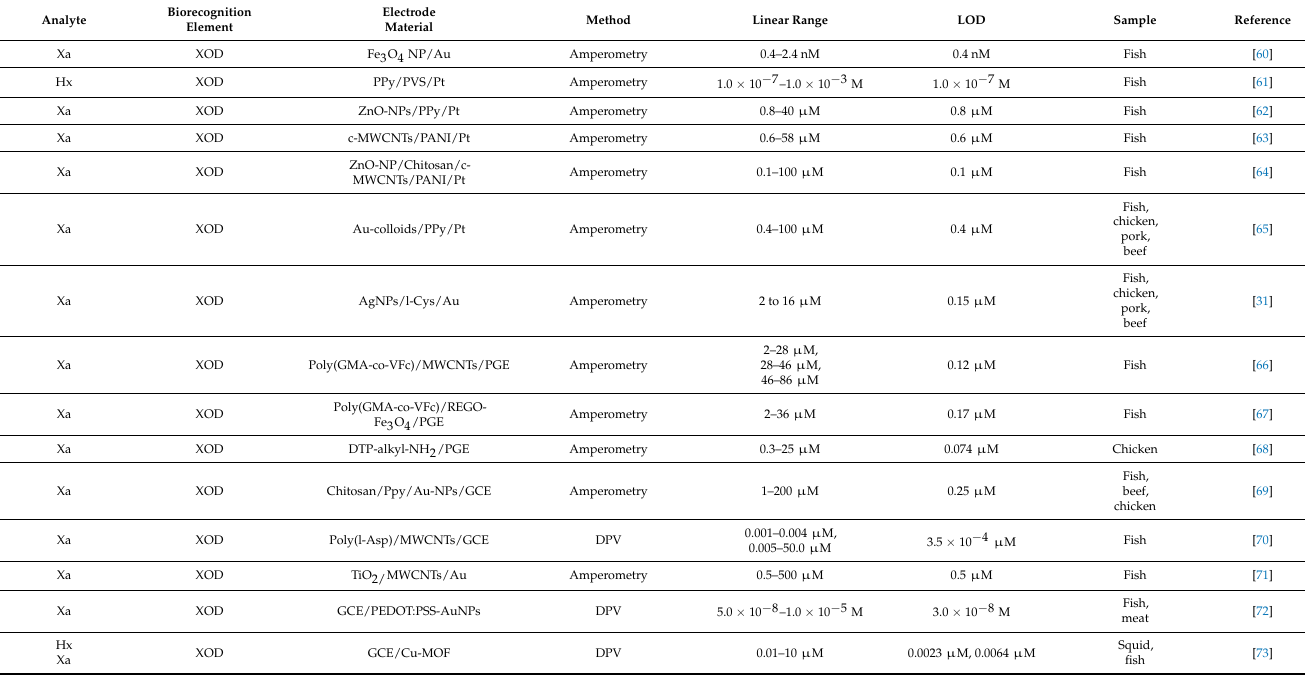
Table 2. Xanthine oxidase-based electrochemical sensors for xanthine